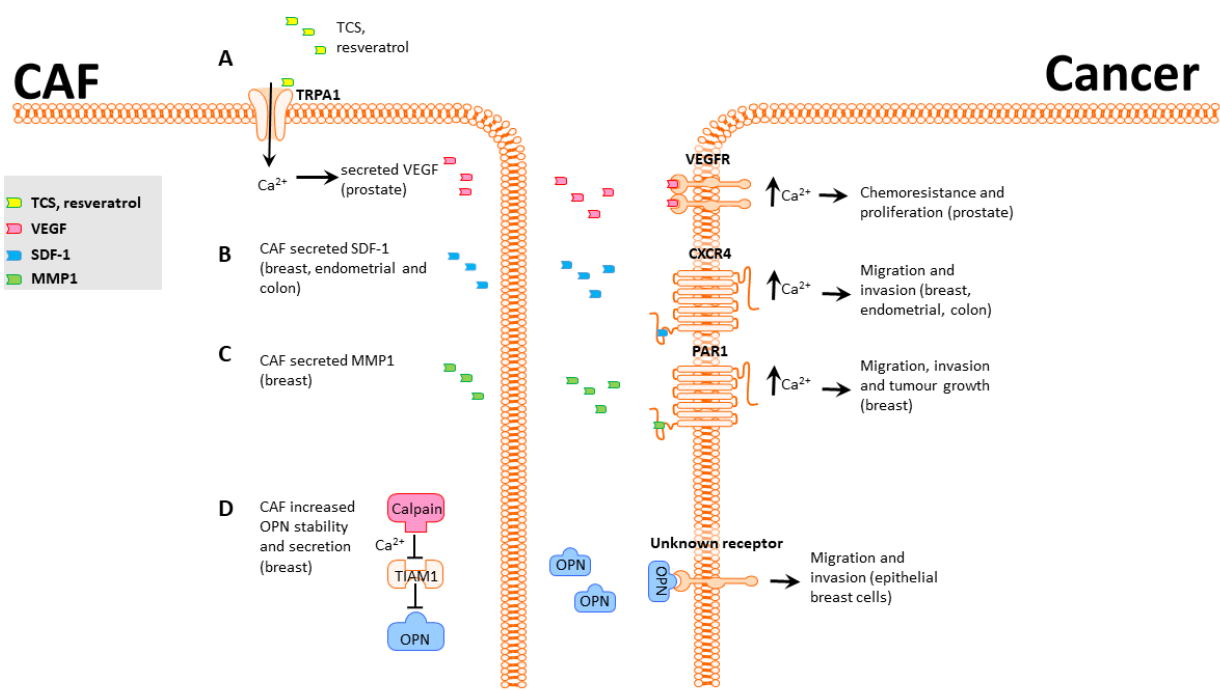
Figure 1. CAF-induced Ca 2+ -mediated phenotypic changes in cancer cells. ( A ), Prostate CAF TRPA1 can be activated by TCS or resveratrol, increasing secretion of VEGF. VEGFR activation in prostate cancer cells induces an increase in cytoplasmic calcium that promotes chemoresistance. ( B ), Breast, endometrial, and colon CAFs secrete SDF-1, which activates CXCR4 in cancer cells and induces an increase in [Ca 2+ ] CYT that promotes migration and invasion. ( C ), Breast CAFs secrete MMP1 and cleave and activate PAR1, leading to increased [Ca 2+ ] CYT and enhanced migration, invasion, and tumor growth in breast cancer cells. ( D ), Breast CAFs degrade TIAM1 in a Ca 2+ -dependent manner. This increases levels of the secreted factor OPN1, which activates an unknown receptor in breast cells and promotes migration and invasion.